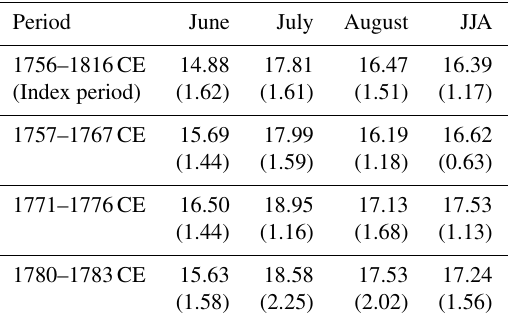
Table 2. Dry periods in the second half of the 18th century in Swe- den reflected in instrumental measurements. Average monthly tem- perature for three